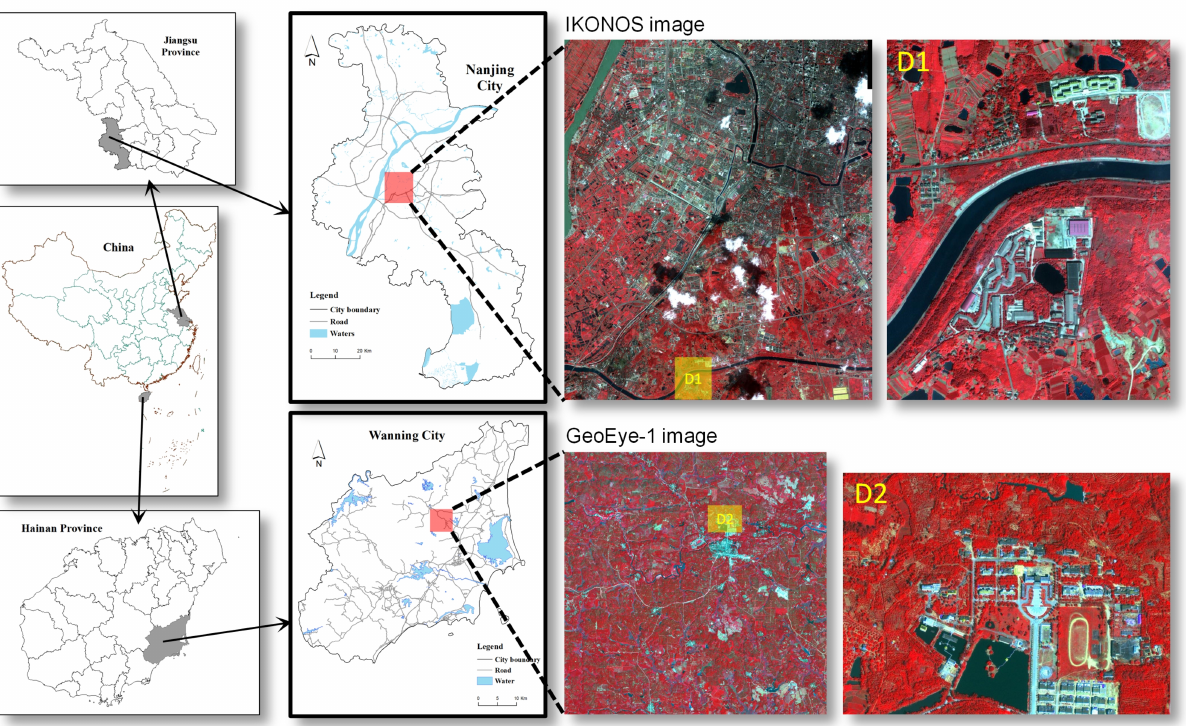
Figure 1. Location of the study area and the datasets used to present remote-sensing image segmen- tation